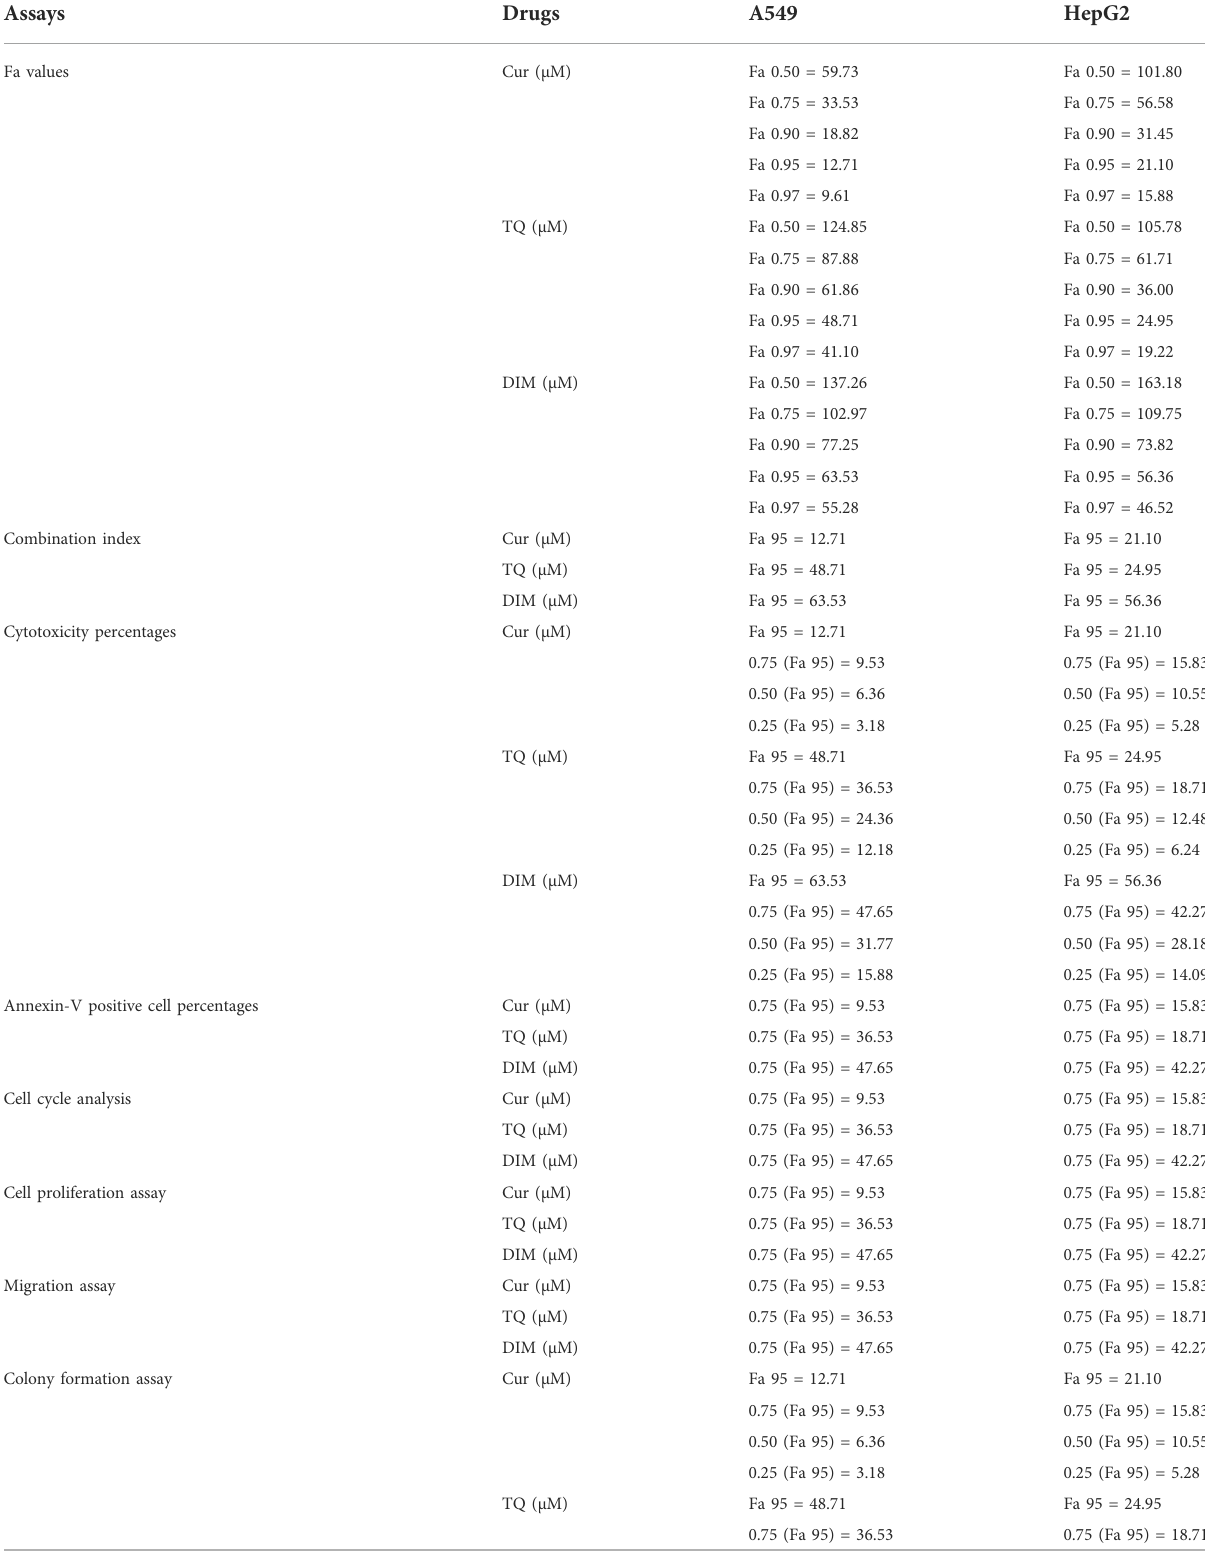
TABLE 2 Summarizes the data of Fa values and the concentrations of curcumin (Cur), thymoquinone (TQ), 3,3 9 -diindolylmethane (DIM) and their combinations that used in all